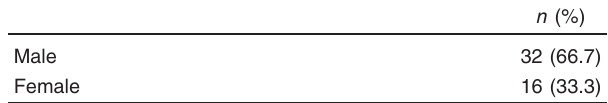
Table 1 Sex distribution of patients on mechanical ventilation in